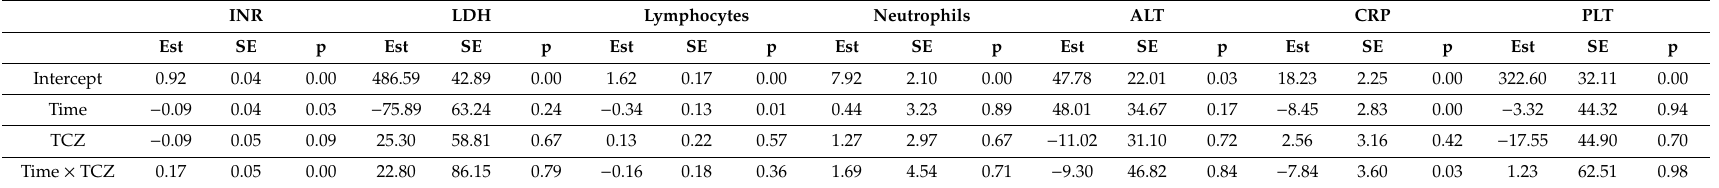
Table 4. E ff ect of Tocilizumab on laboratory